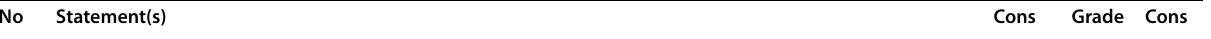
Table 5 Section 2: Structural points, key issue 4: Quality Management Key question : What does suitable quality management entail for the radiological care of polytrauma patients?